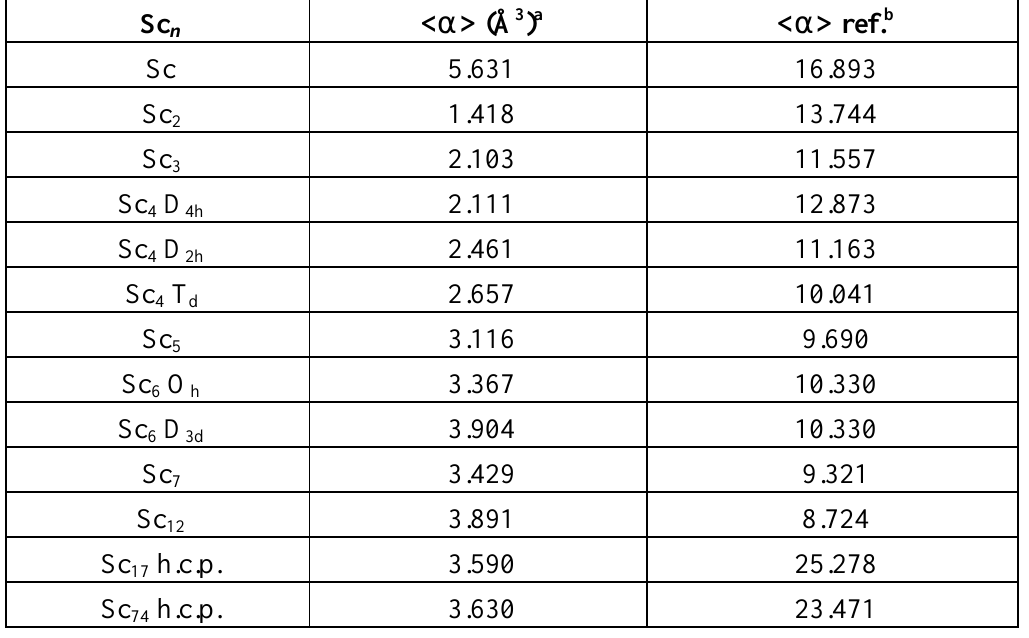
Table 1. Elementary dipole-dipole polarizabilities for